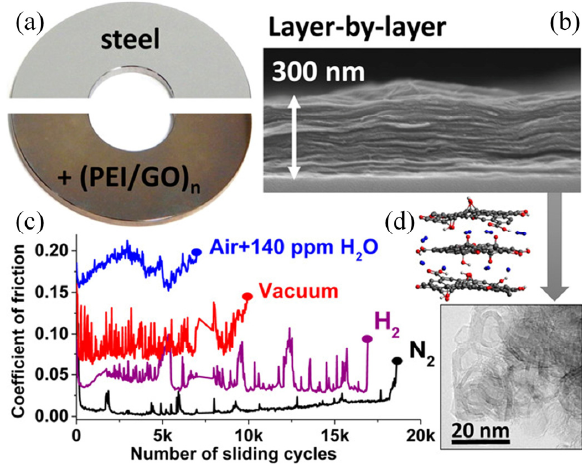
Figure 8. Multilayer design of PEI/GO coatings. ( a ) Photograph of the steel substrate and that deposited with multilayer PEI/GO coatings; ( b ) cross-sectional morphology of a PEI/GO coating with 15 bilayer periods; ( c ) COFs of the multilayer coatings under different test environments; ( d ) HRTEM image of the wear debris containing GO in N 2 environment. Reprinted with permission from [124].